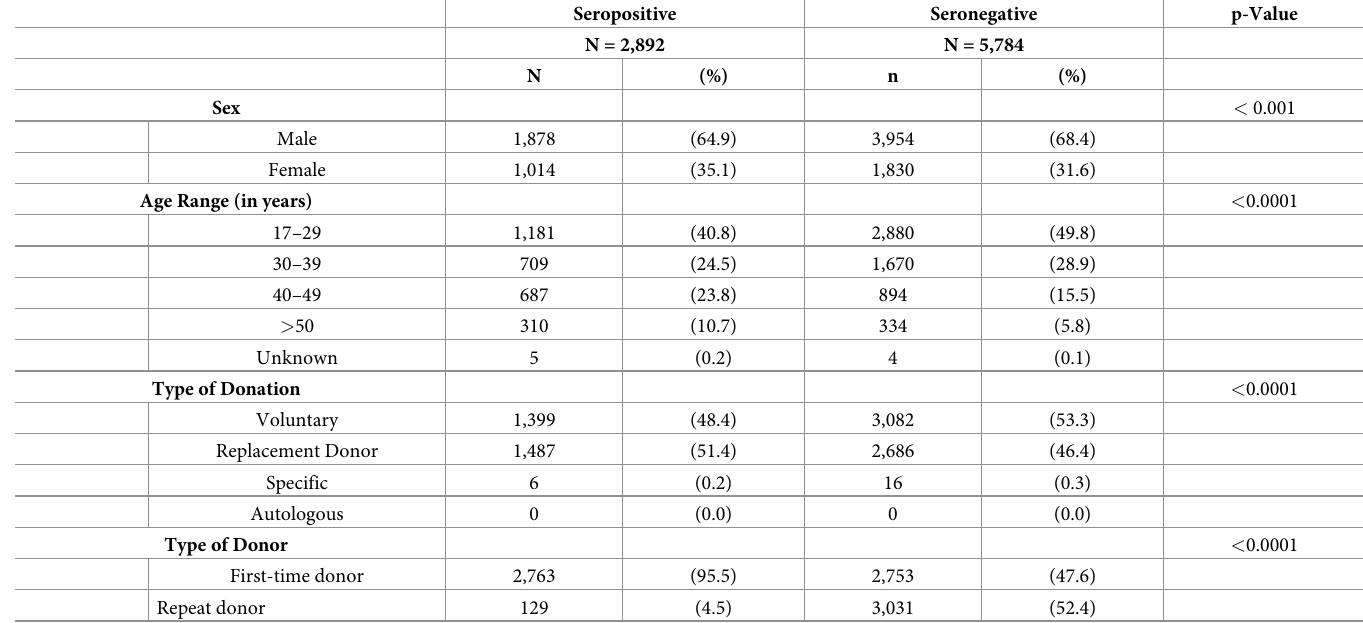
Table 1. Demographic characteristics of the study population organized by HCV serological status.